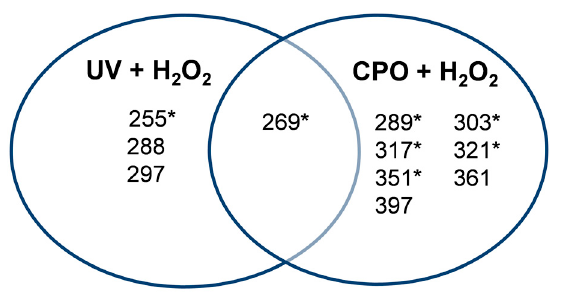
Figure 4. Summary of the intermediates produced upon ThT degradation by UV + H 2 O 2 and CPO + H 2 O 2 processes. The asterisk (*) indicate intermediates whose structures are shown in Figure 6A,B.